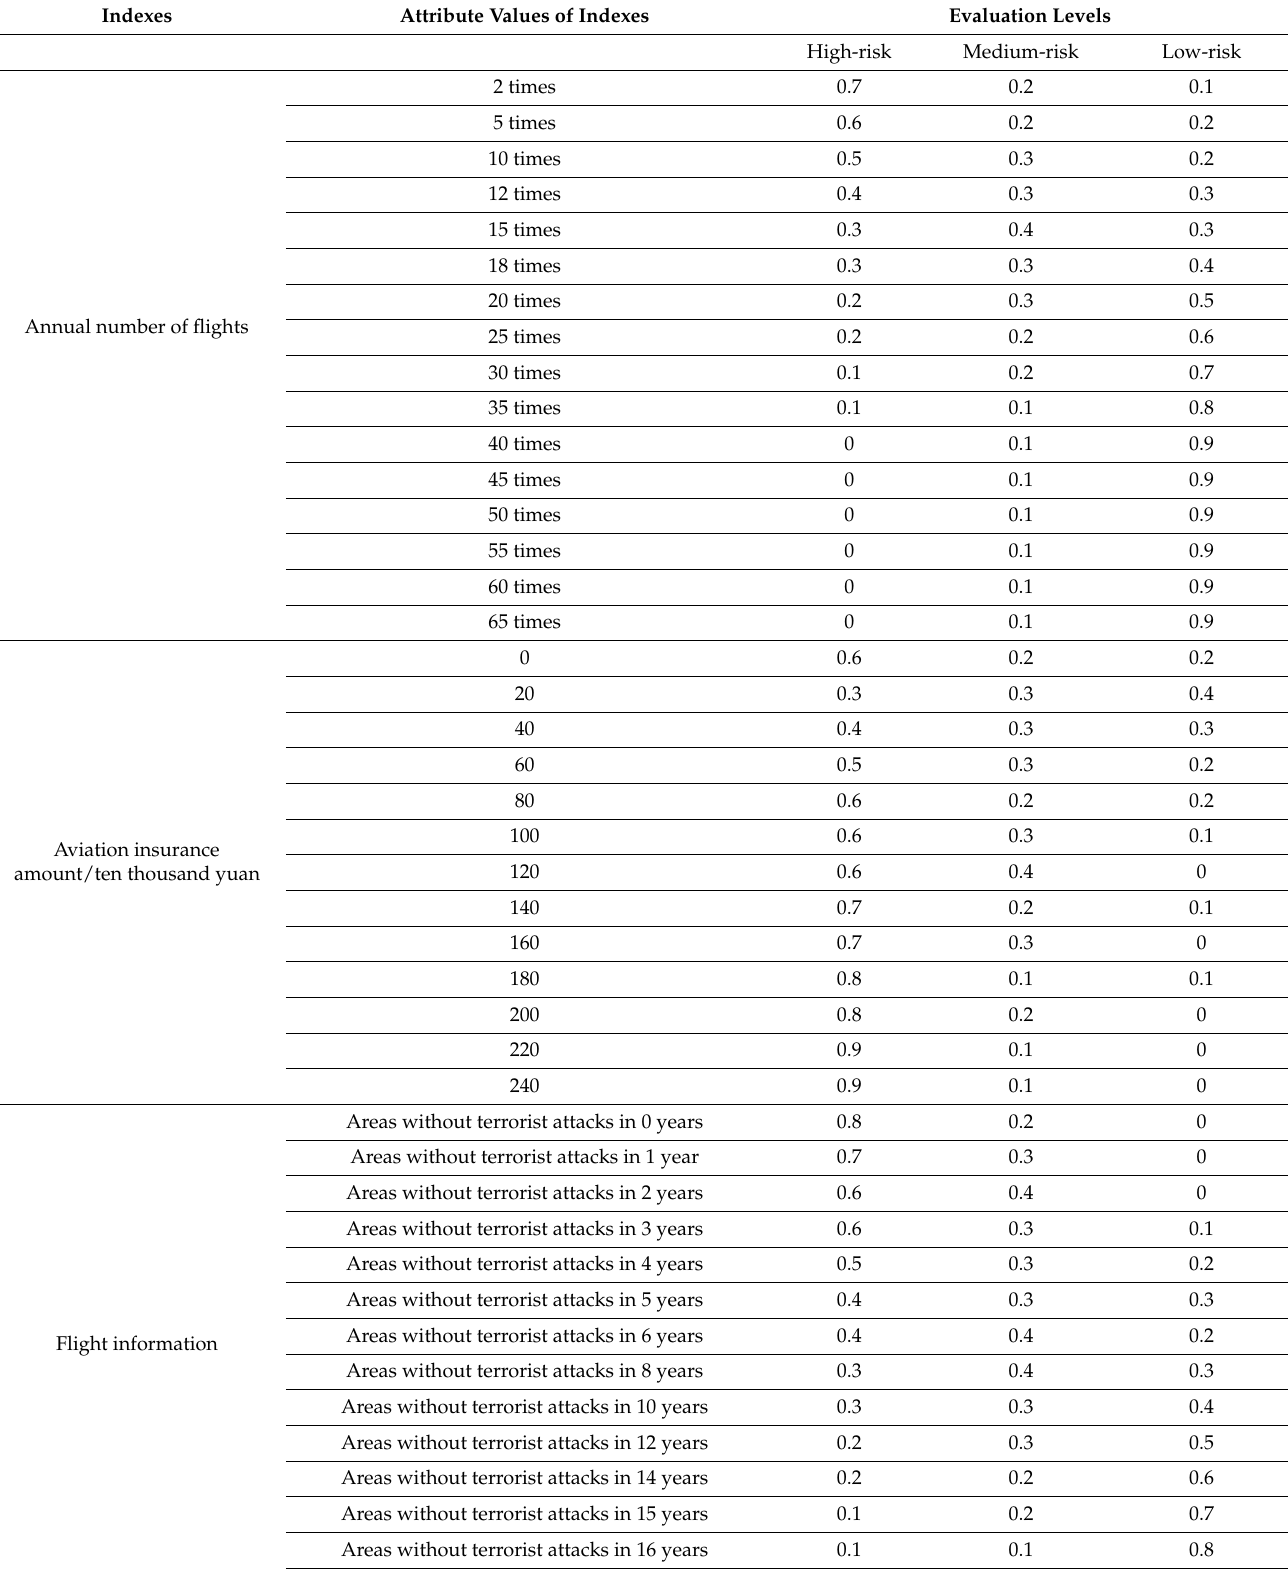
Table A16. Single factor evaluation of civil aviation travel record